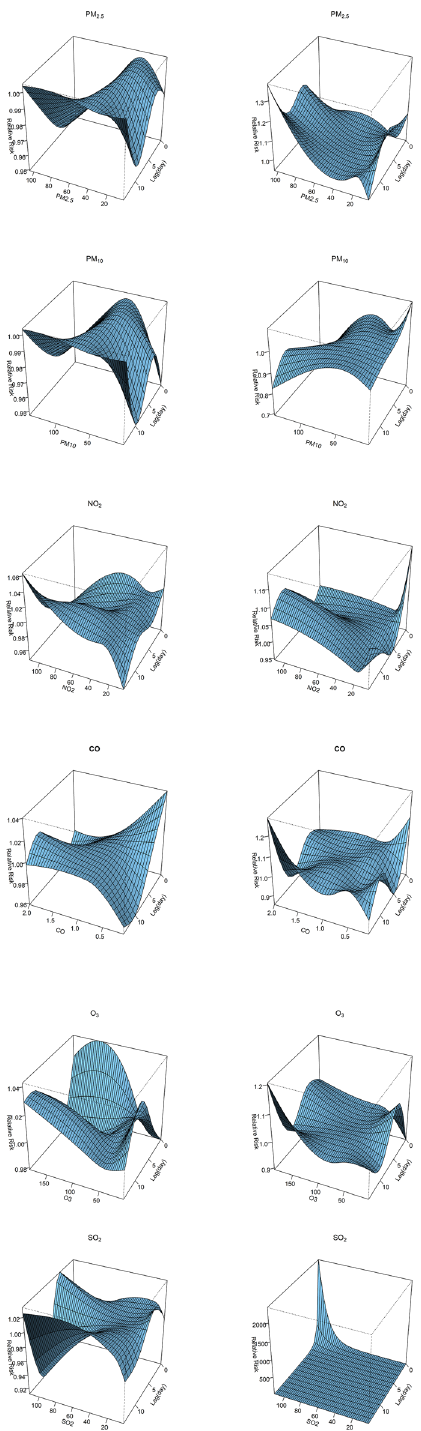
Figure 5. Relationships between air pollutants and HFMD over the 0–14 days lag period in the basin region (left) and plateau region